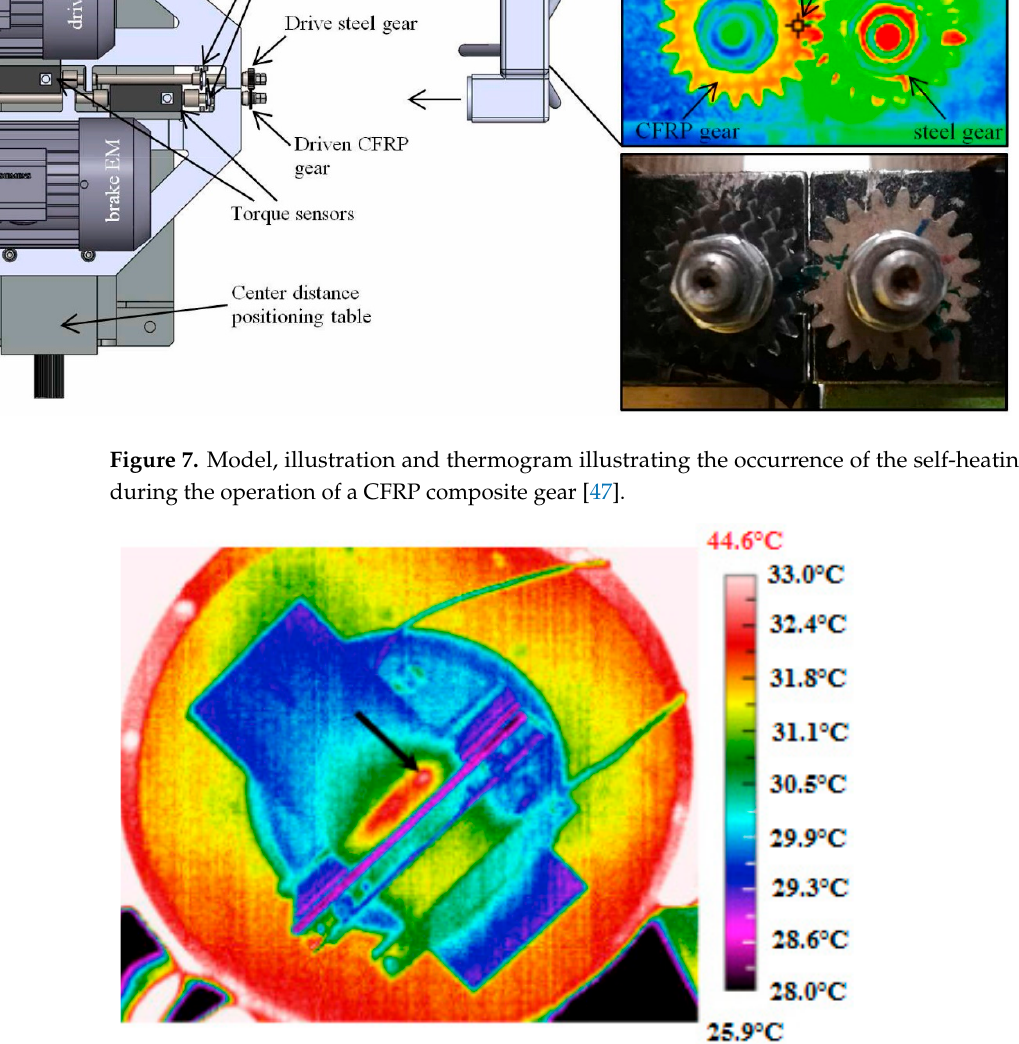
Figure 8. Thermal failure in a composite blade due to the self-heating effect shown by the arrow, adapted with permission from Ref. [28]. Copyright © 2016 Elsevier